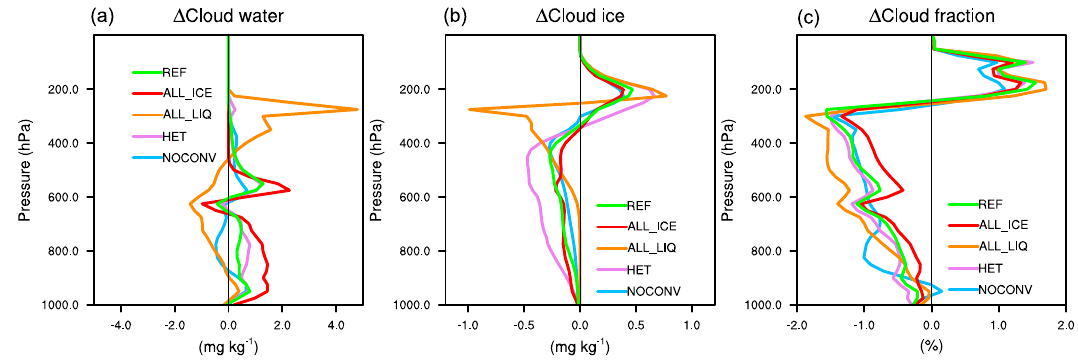
Figure 7. Change in the annual global mean cloud liquid water content (LWC, a ) and ice water content (IWC, b ) in milligrams per kilogram as a function of pressure in hectopascals between the 2 × CO 2 and 1 × CO 2 climates for the simulations described in Table 1.